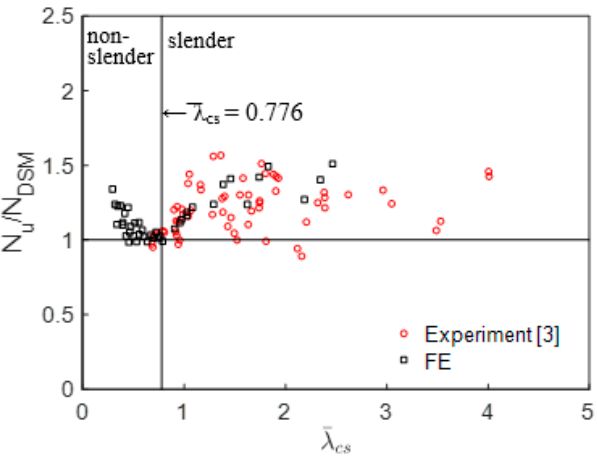
Figure 13. Assessment of DSM design strength predictions.